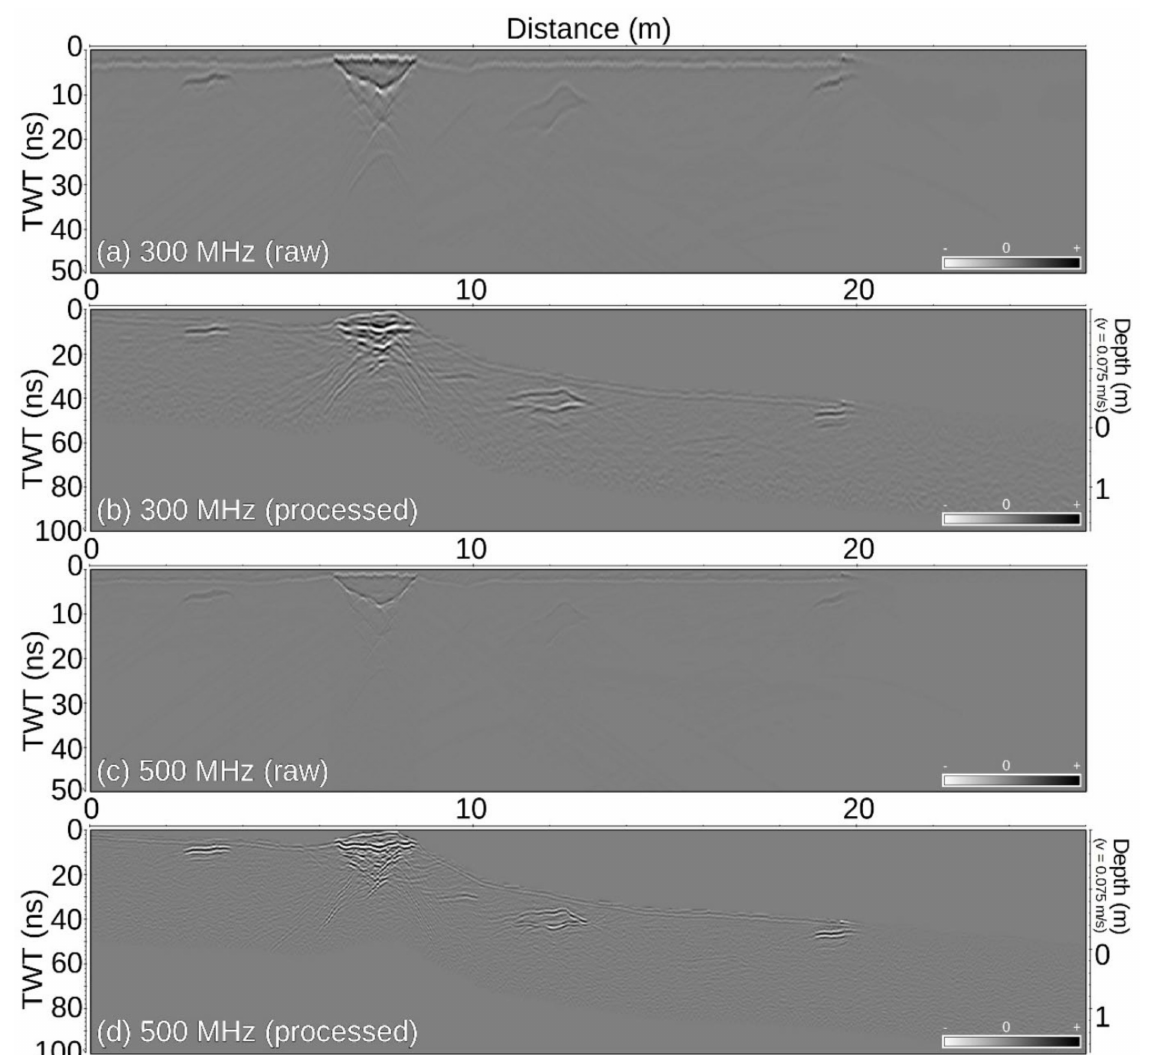
Figure 9. GPR synthetic data derived from model 2, simulating cololites and fossiliferous beds located at increasing depth, and including high conductivity shallow layers, physical properties perturbations, real topography, and white noise; ( a ) raw synthetic data from 300 MHz simulation displaying the deeper reflections from cololites and fossiliferous beds are not visible; ( b ) processed 300 MHz synthetic profile (including amplitude recovery and static correction steps), illustrating strong and moderate amplitude of reflections at shallow and intermediate depth. The simulated altered top deposit on the right side causes total radar signal attenuation, highlighted by the fossiliferous bed visible only on its left side; ( c ) raw synthetic data from 500 MHz simulation displaying the same reflections of ( a ) with high resolution but progressively weaker amplitude with depth; ( d ) processed 500 MHz synthetic data (including amplitude recovery and static correction steps), where it is almost possible to detect the deeper simulated cololite, whose reflection is very weak due to high attenuation and being embedded within the random